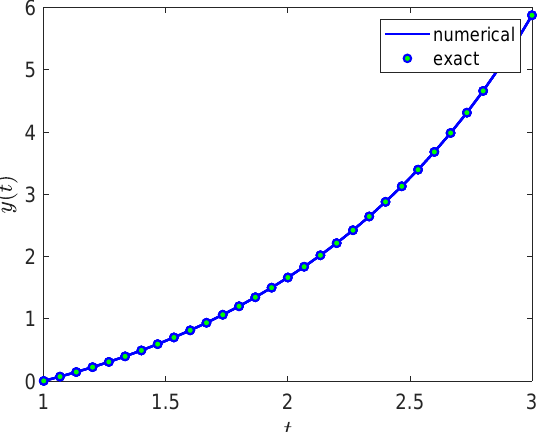
Figure 10. Graphs of the exact and approximate solutions for example